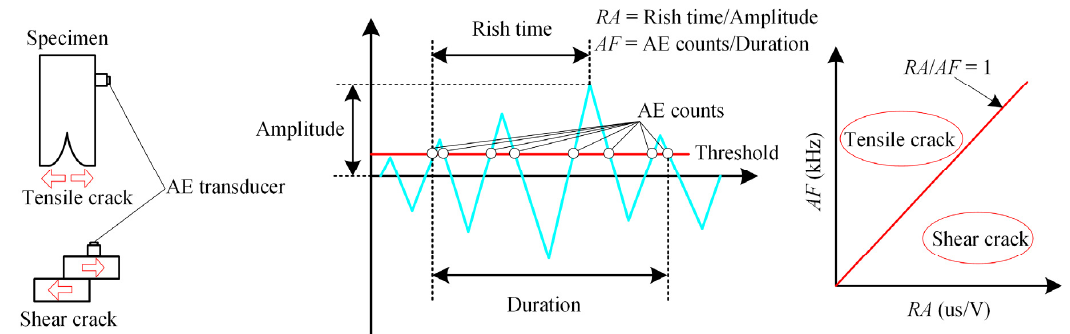
Figure 5. Schematic diagram of crack mode and acoustic emission (AE) characteristic parameters.